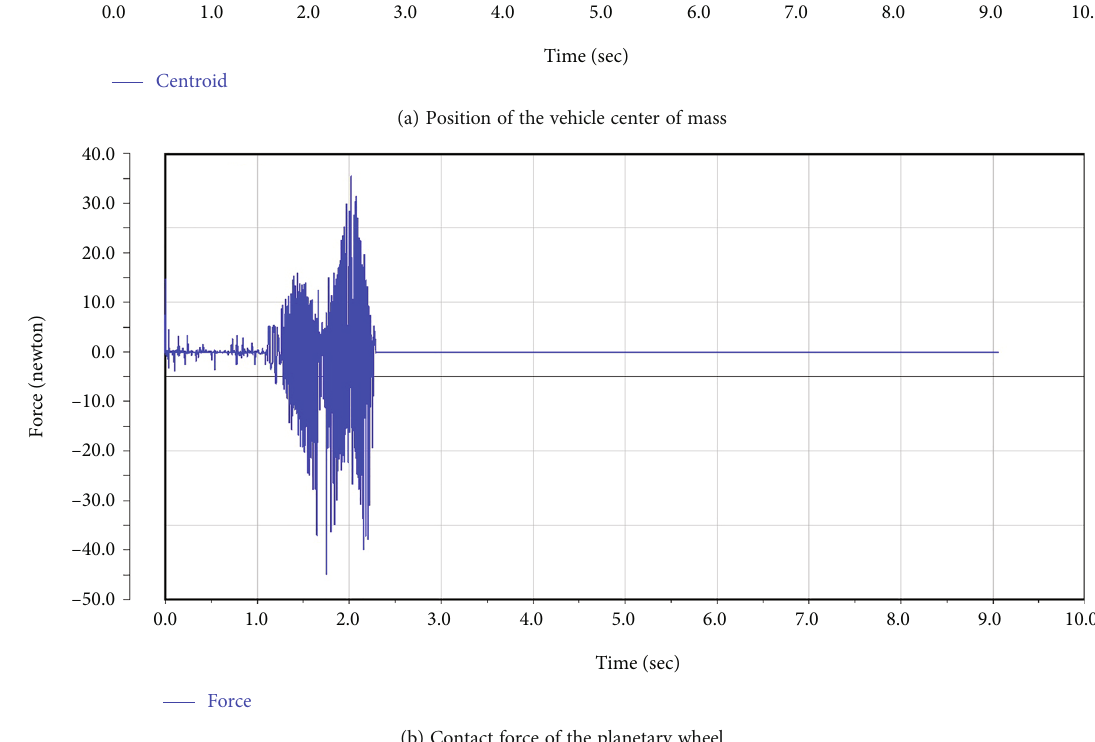
Figure 9: Kinematics curves of the main vehicle body.